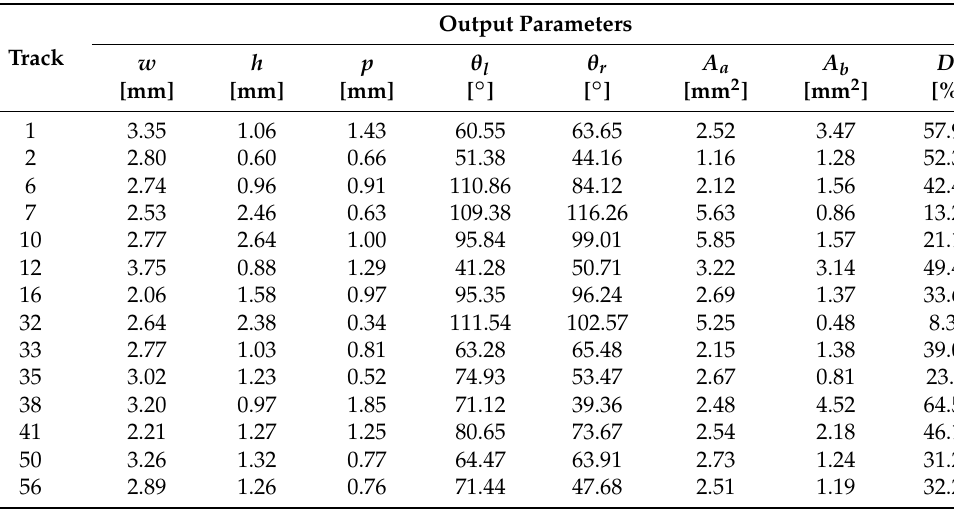
Figure 11. Parametrisation window overlayed with cross-section images of the produced beads: Lower ratios between the scanning speed and feeding rate lead to low dilution proportions and large wettability angles, while increased ratios lead to decreased bead heights. Table 4. Output parameters determined